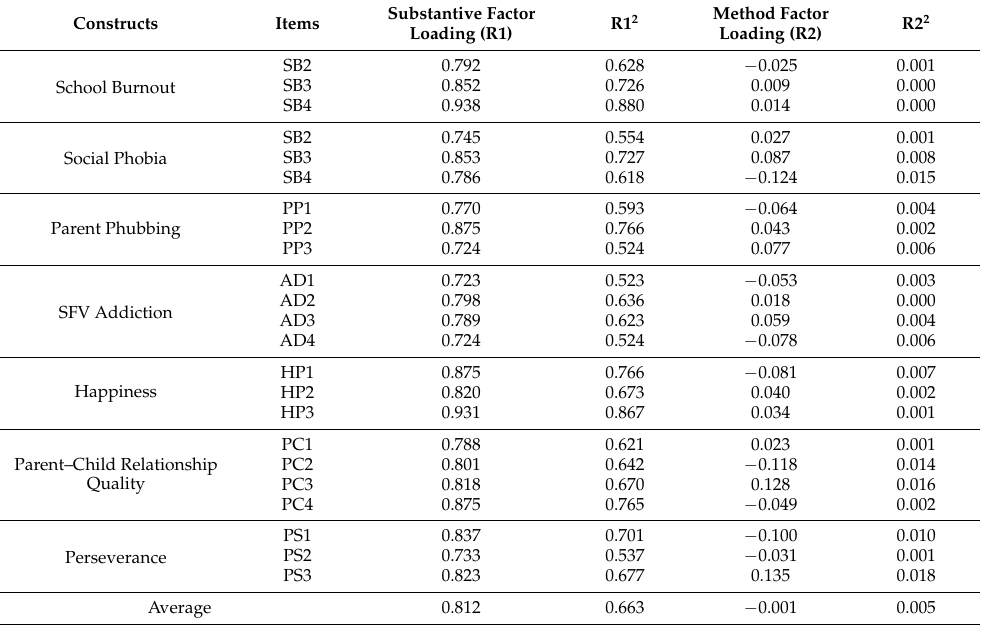
Table 5. Common method bias